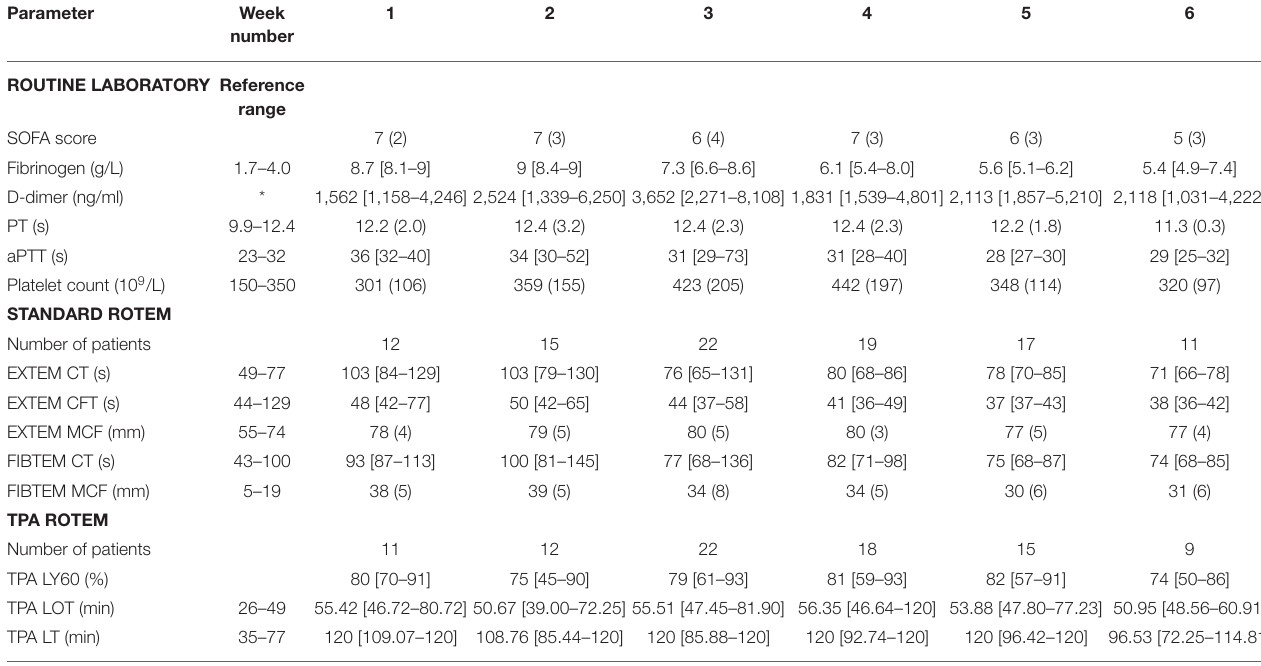
TABLE 2 | SOFA score, routine laboratory, standard ROTEM, and tPA ROTEM in COVID-19 patients per week from intubation.